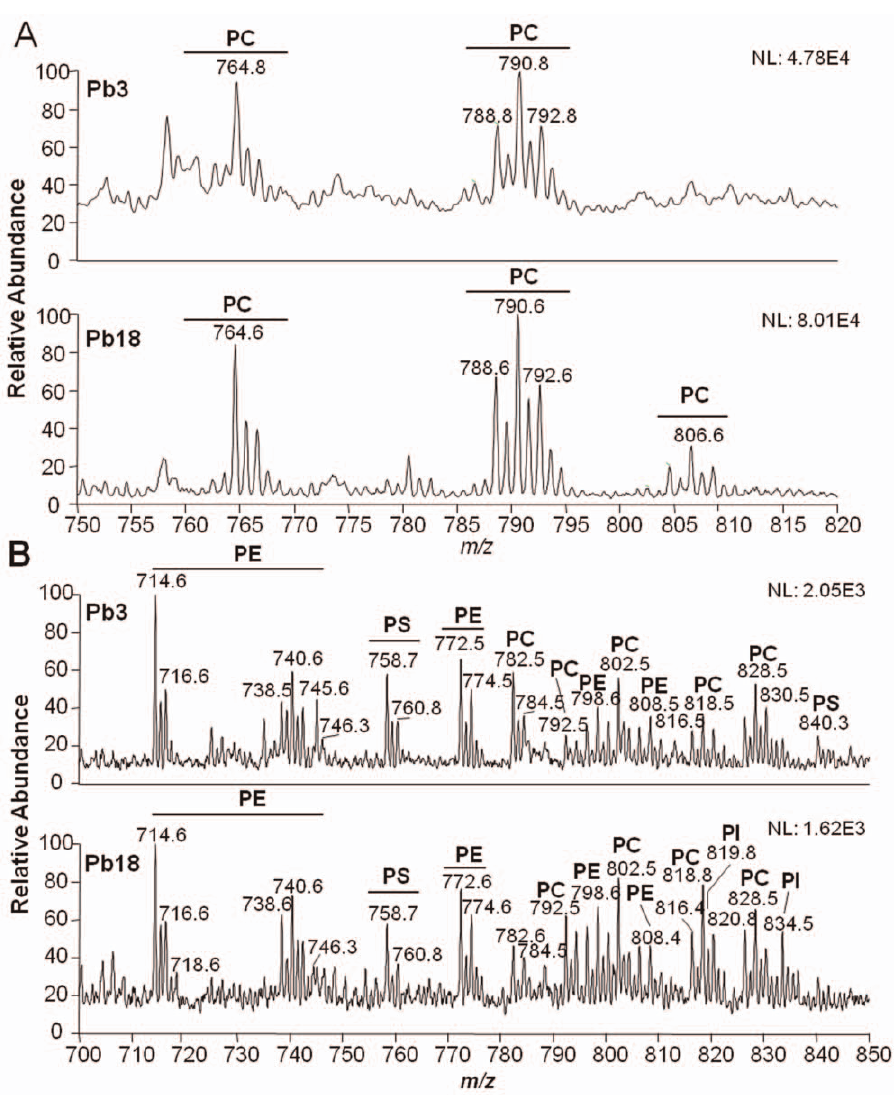
Figure 1. Phospholipid analysis of Pb3 and Pb18 extracellular vesicles by ESI-MS/MS. Phospholipid-enriched fractions from total extracellular vesicle lipids were analyzed by ESI-MS in the (A) positive- and (B) negative-ion modes, followed by total-ion mapping (TIM) fragmentation. The ion species corresponding to the identified phospholipids are indicated as follows: phosphatidylethanolamine (PE), phosphatidylcholine (PC), phosphatidylserine (PS), and phosphatidylinositol (PI). m/z , mass to charge